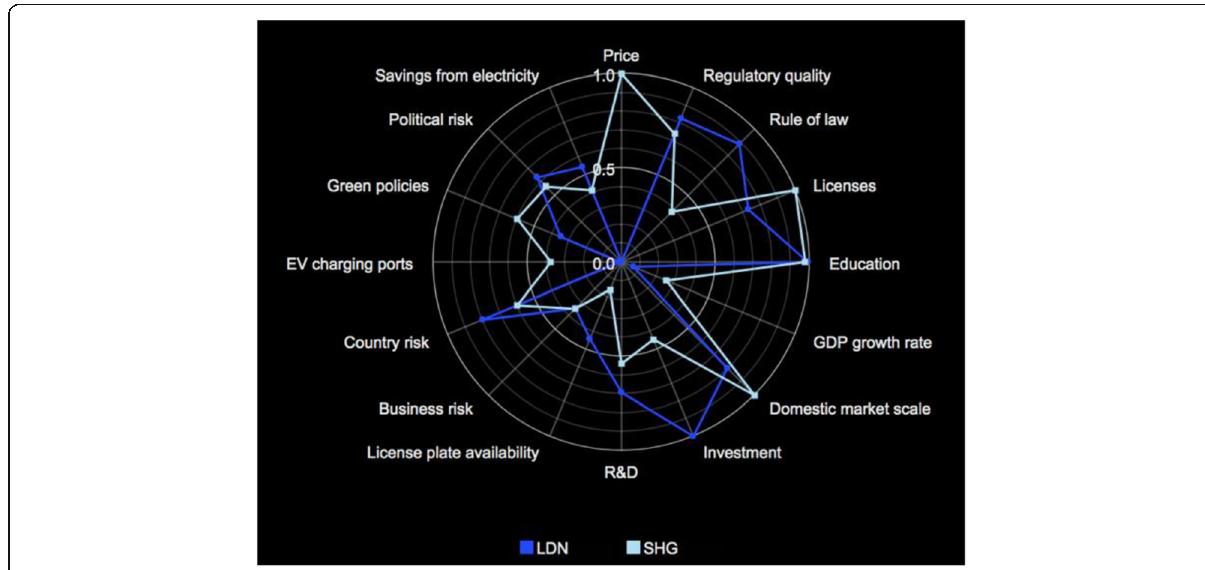
Fig. 2 Equal Weighting: all subcategories (author ’ s